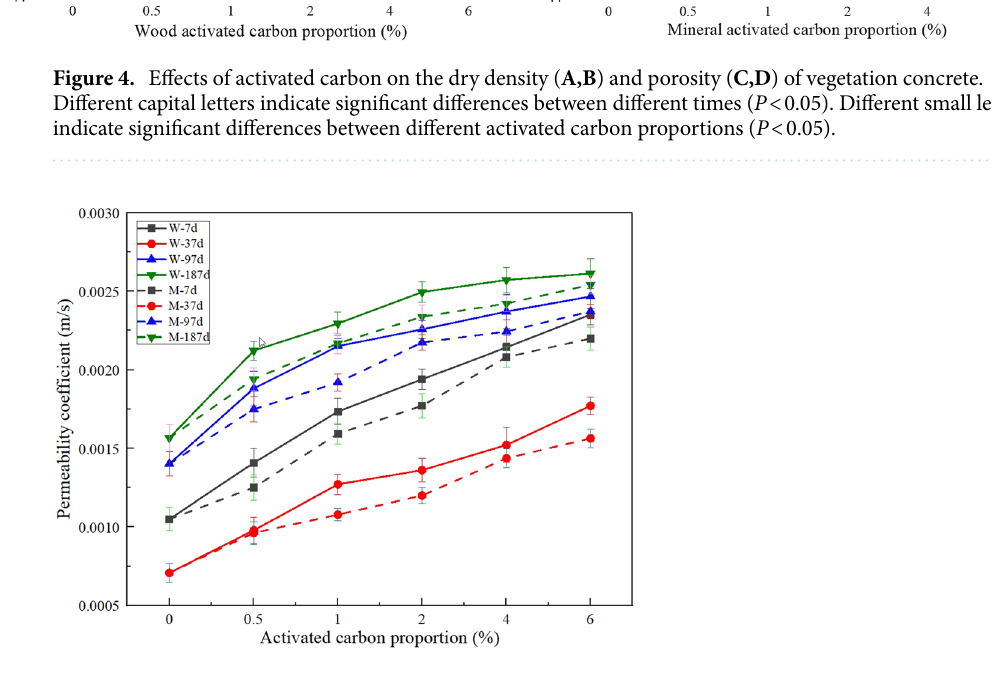
Figure 5. Effect of activated carbon on the permeability coefficient of vegetation